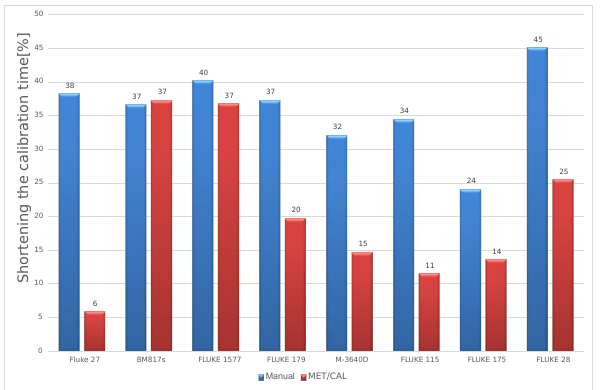
Figure 10. Reduced calibration time.